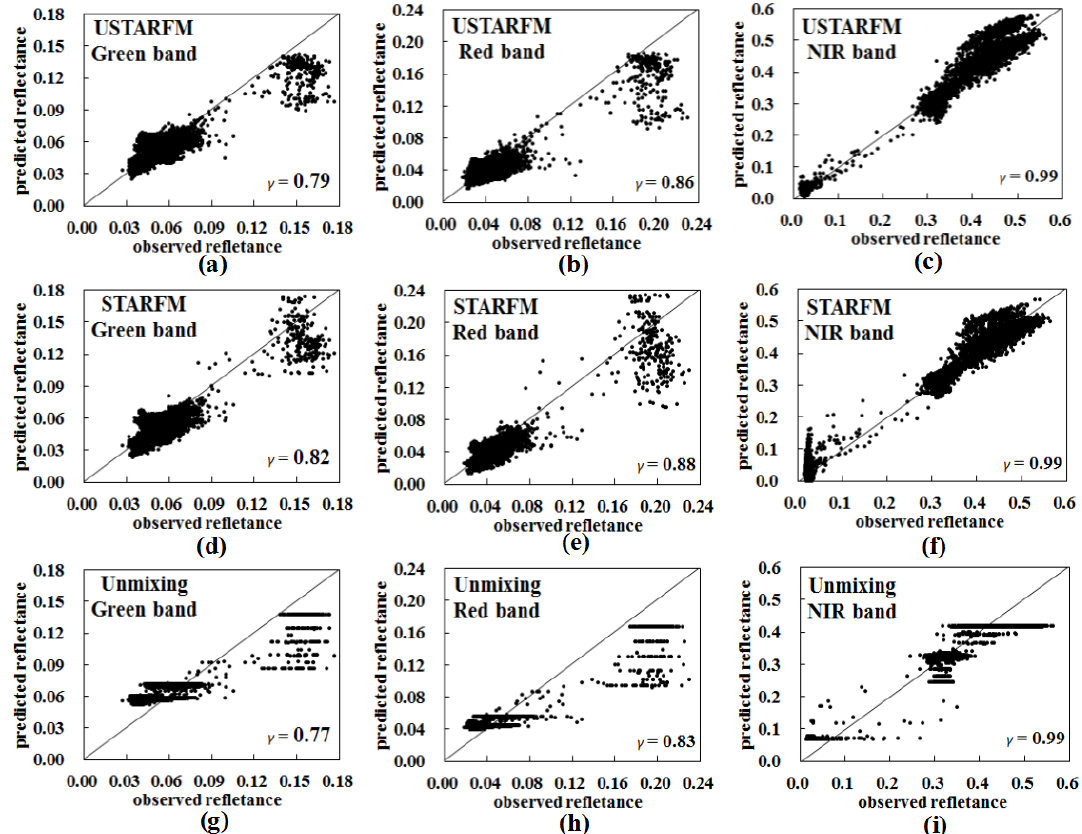
Figure 6. Scatterplots of three bands generated by the three methods in the region with the heterogeneity level of 1.